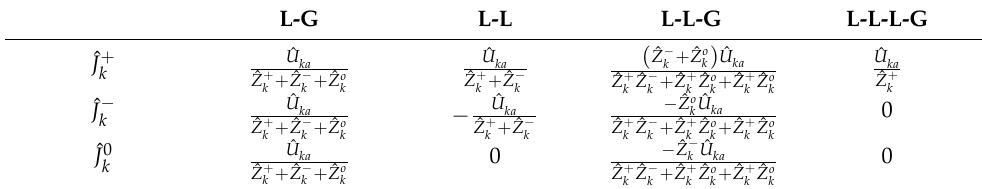
Table 1. Formulae for calculating sequence domain fault currents at fault location. L-G L-L L-L-G